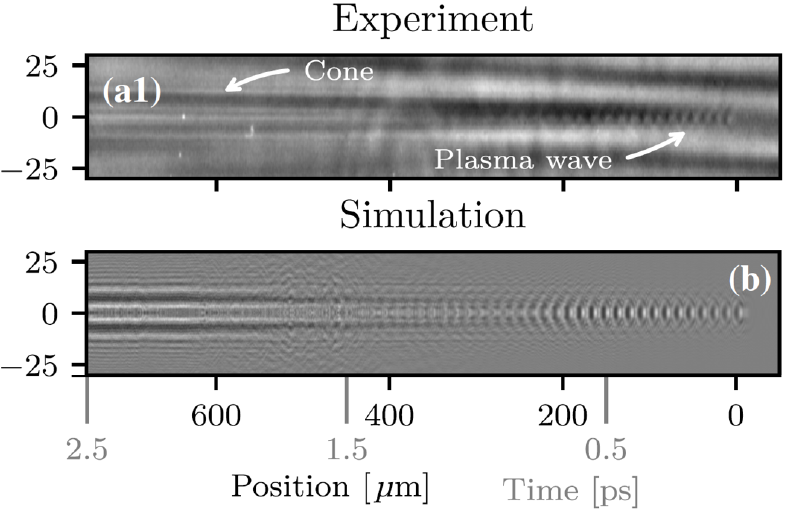
Figure 6. Experimentally imaged plasma wave obtained by shadowgraphy ( a1 ) and corresponding simulation ( b ), illuminating the induced cone-shaped ion motion evolution as a result of the unipolar field kick of the PWFA (figure adapted from